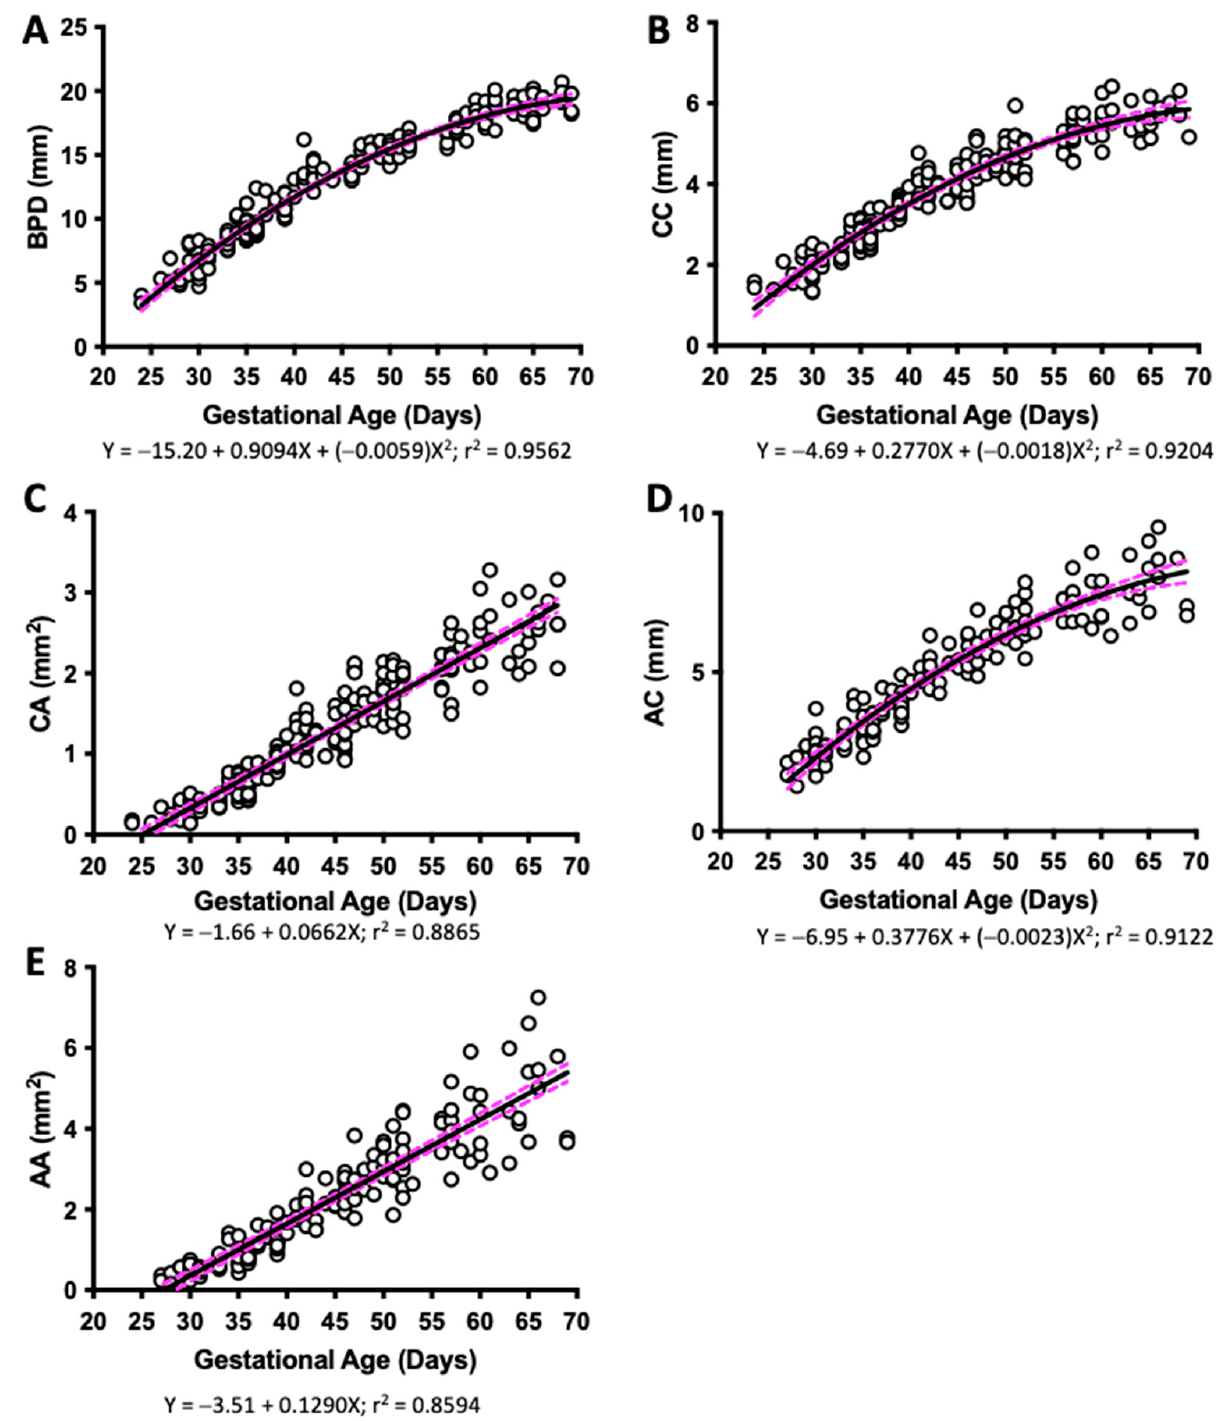
Figure 1. Fetal biometry across pregnancy. Guinea pig fetal ( A ) biparietal diameter (BPD), ( B ) cranial circumference (CC), ( C ) cranial area (CA), ( D ) abdominal circumference (AC), and ( E ) abdominal area (AA), and their best fit from gestational day 25 to the end of pregnancy. Each dot represents an individual measurement (n = 47 from 19 litters). Black line = data best fit. Magenta dashed lines = 95% CI.